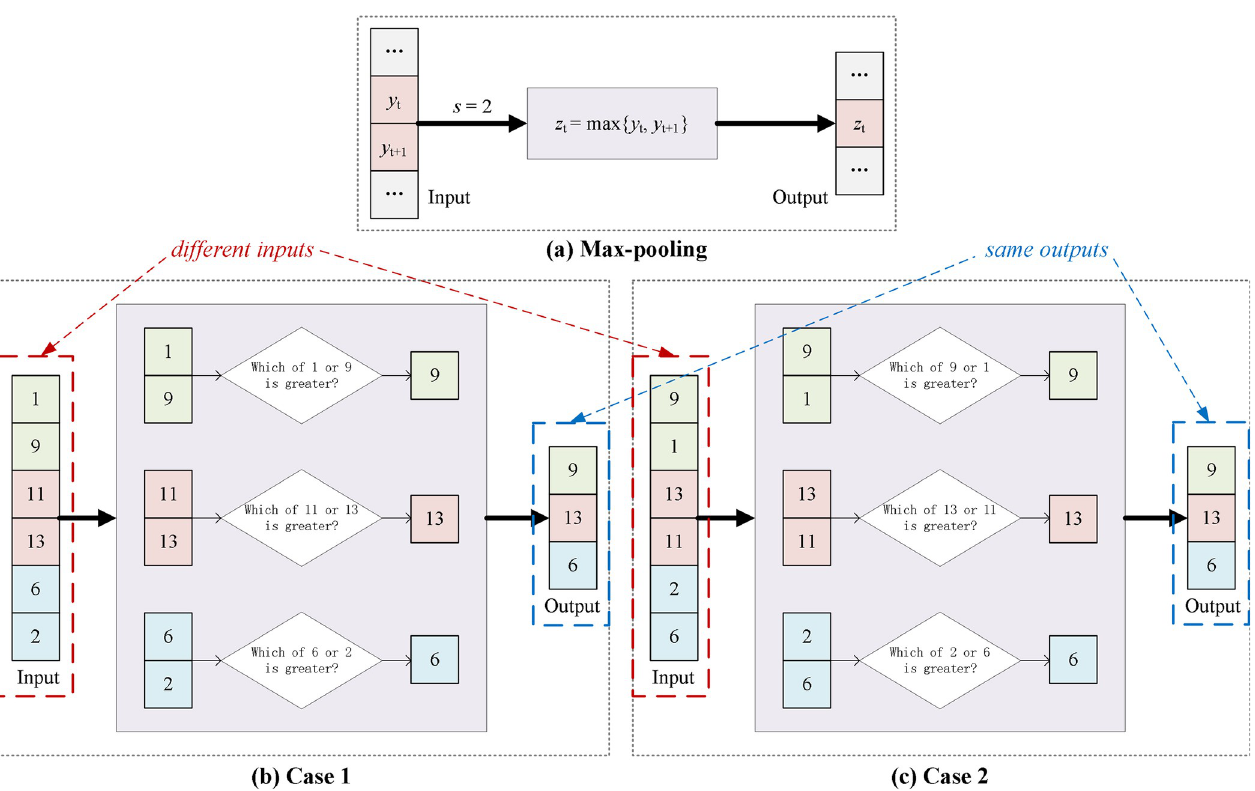
Fig 1. The procedure of the max-pooling layer. (a) The featurewise operation will result in information losses, where y t is the t -th element of the input, z t is the output, s p is the pooling size and s s is the stride ( s p = s s = s = 2). (b, c) Examples of the invariance characteristic. Case 1 and 2 are different in the order. The output of the max-pooling layer cannot reflect small input changes, losing important sequential information.